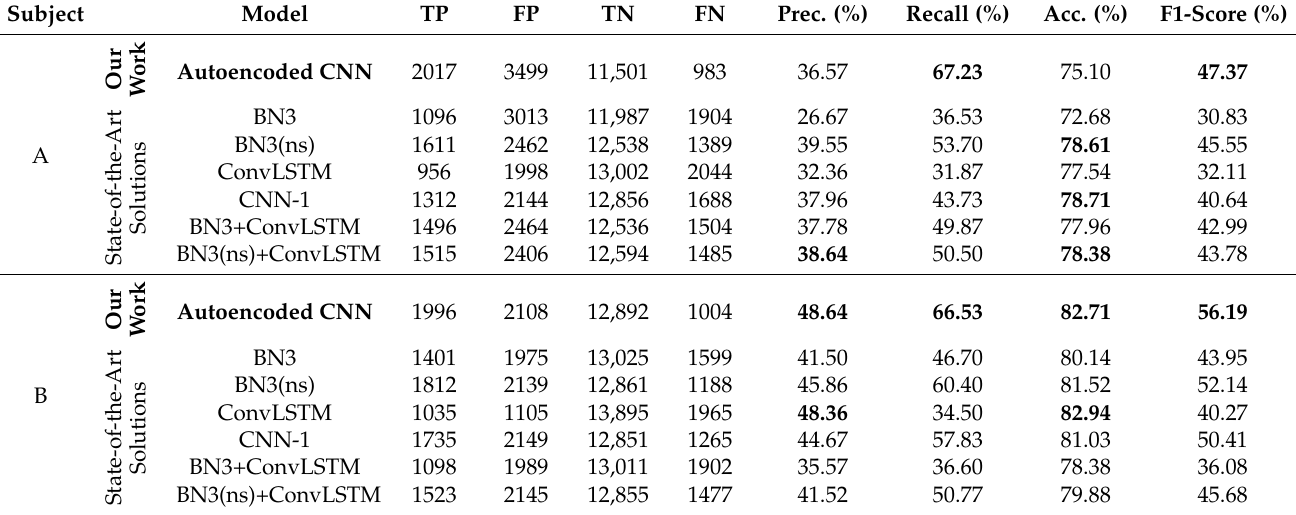
Table 6. LBP impact on different state-of-the-art neural network architectures.